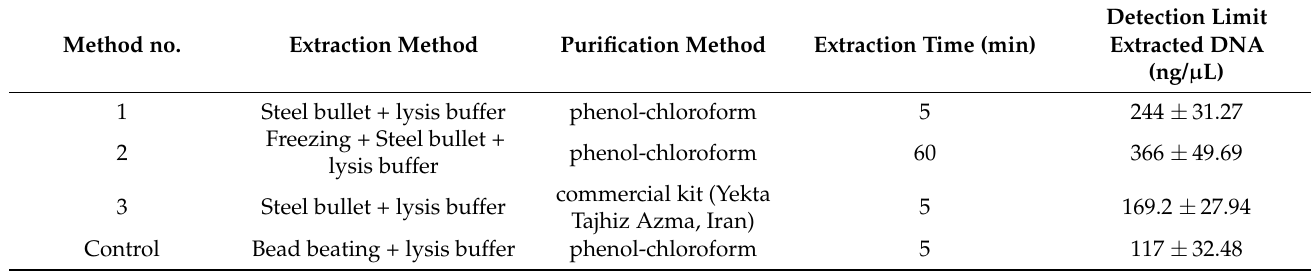
Table 4. Steel-bullet protocols adapted from Motamedi et al. [40].